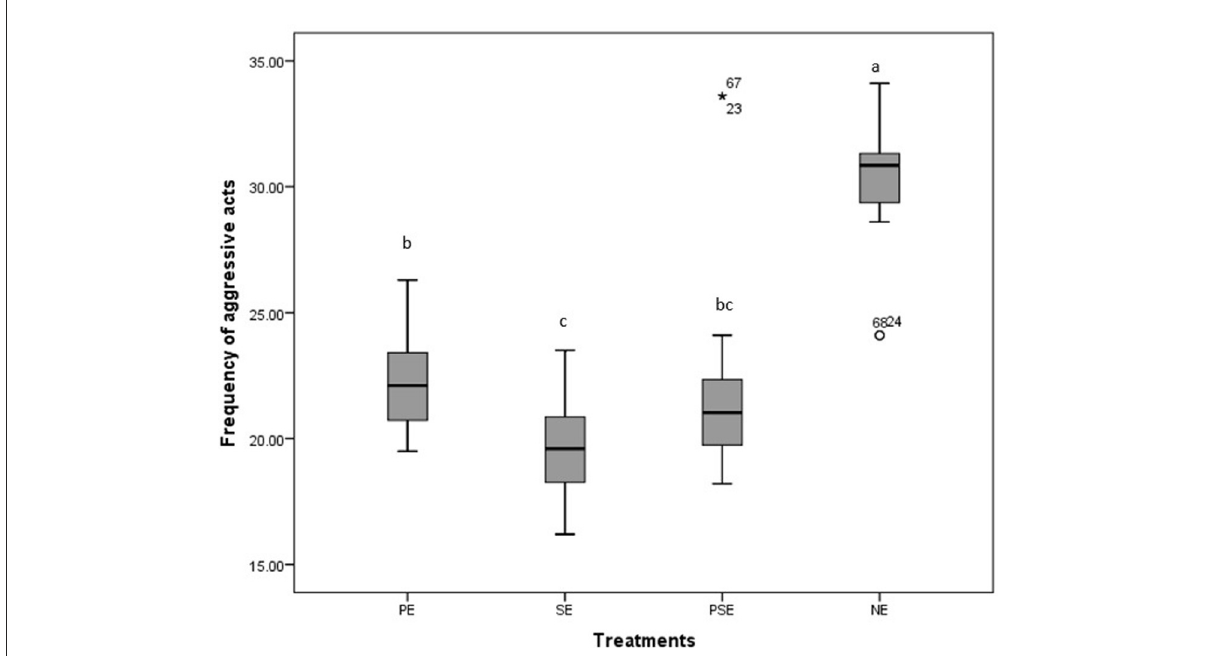
FIGURE5 Boxplot of the effect of environmental enrichment during 600seconds on the frequency of aggressive acts displayed by juveniles of Clarias gariepinus under laboratory conditions. abcd Mean values with different superscripts were significantly ( p < 0.05) different between treatments.